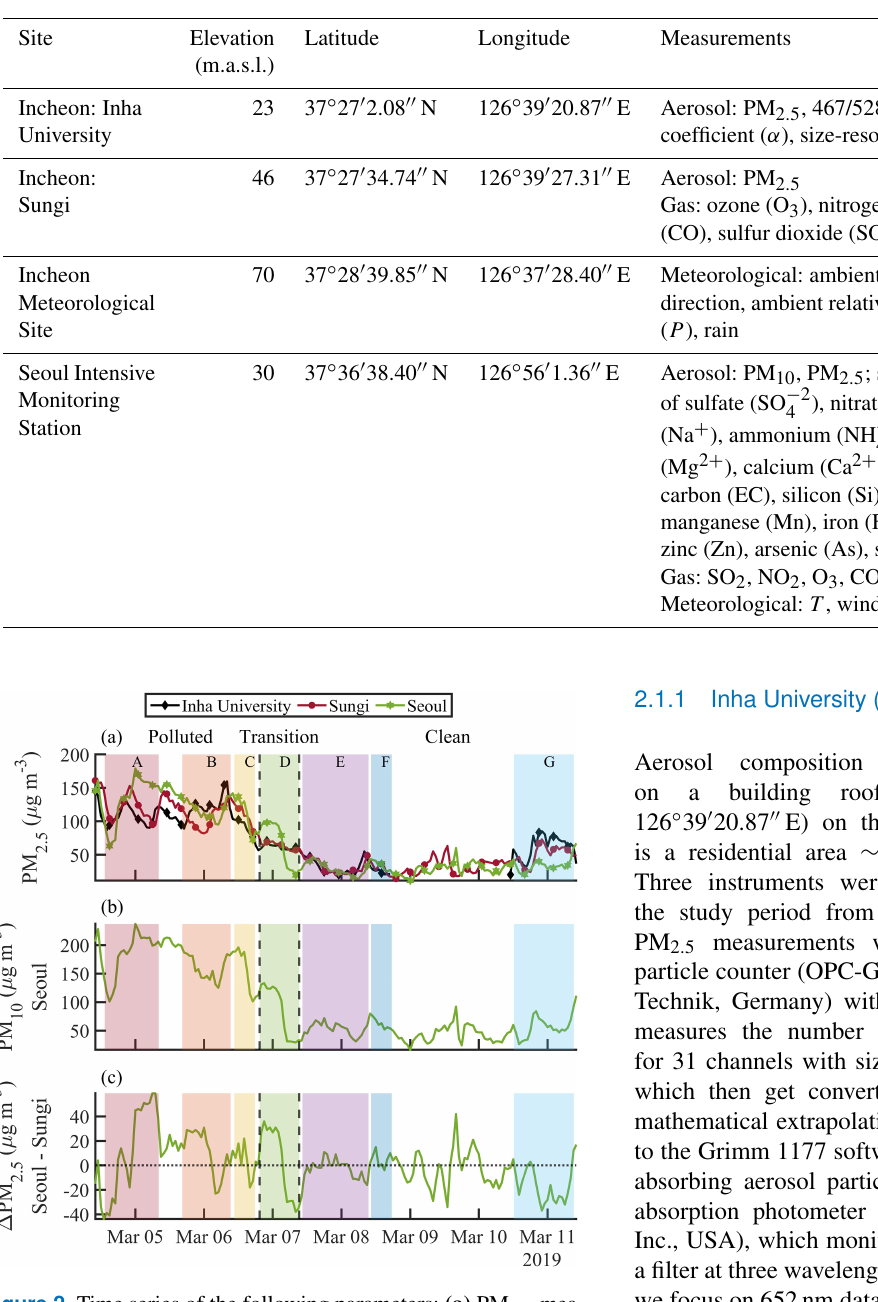
Table 1. Sample site name, elevation in meters above sea level (m.a.s.l.), latitude and longitude coordinates of each site, and the parameters measured at each site.